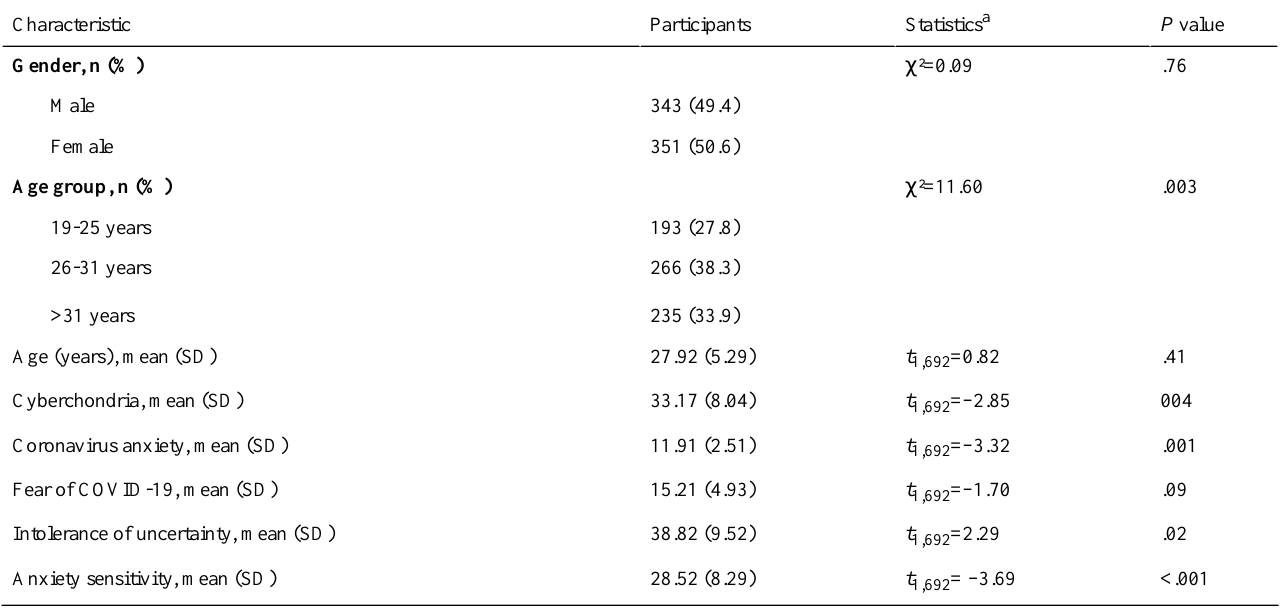
P valueStatistics a ParticipantsCharacteristic